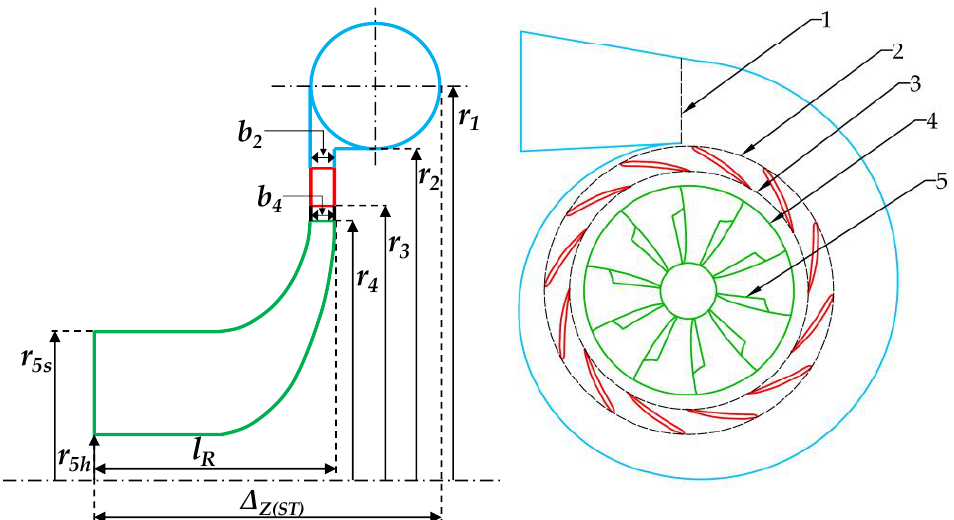
Figure 6. Schematic representation of turbine geometry. The numbers refer to the following main flow sections: (1) volute inlet (2), nozzle inlet, (3) nozzle outlet; (4) rotor inlet, (5) rotor exit.